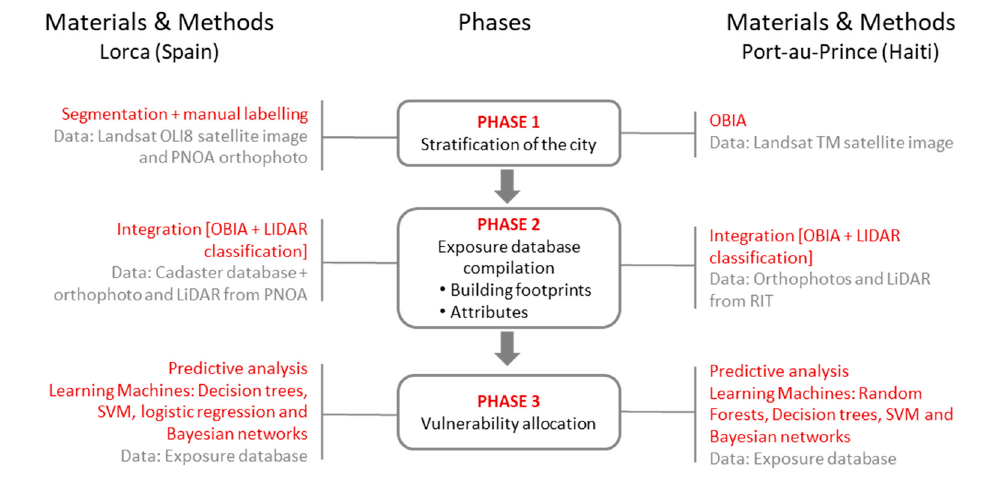
Figure 1. Methodological scheme. Materials and methods are indicated for both scenarios, Lorca (left) and Port-au-Prince